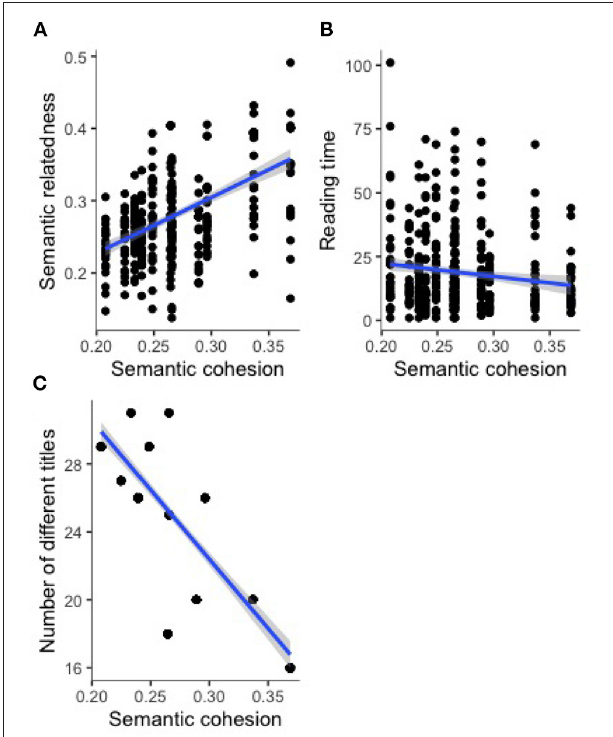
FIGURE 2 | Explicit measures: Relationship between semantic cohesion and semantic relatedness between titles and poems (A) , mean reading time (B) , and number of different titles (C) .